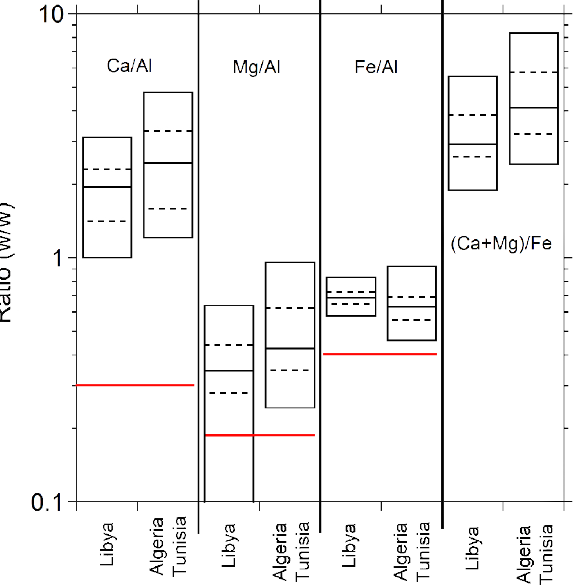
Fig. 8. Percentile distribution of Ca/Al, Mg/Al, Fe/Al and (Ca + Mg)/Fe ratios for the two dust source regions evidenced in Fig. 7. The top and bottom of each box show the 5th and 95th per- centiles. The middle line shows the median value, and the dashed lines show the 25th and 75th